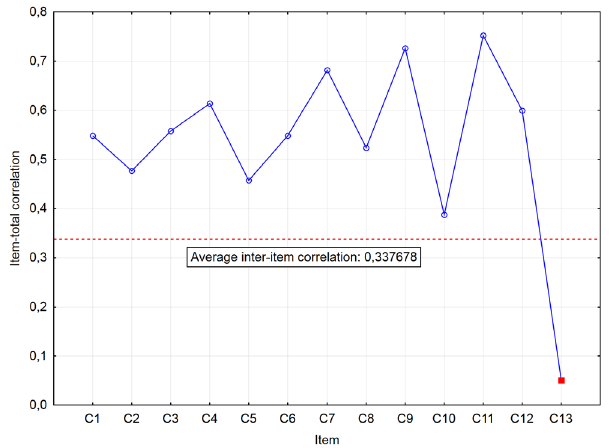
Fig. 4. Correlations of the particular items with the total questionnaire score